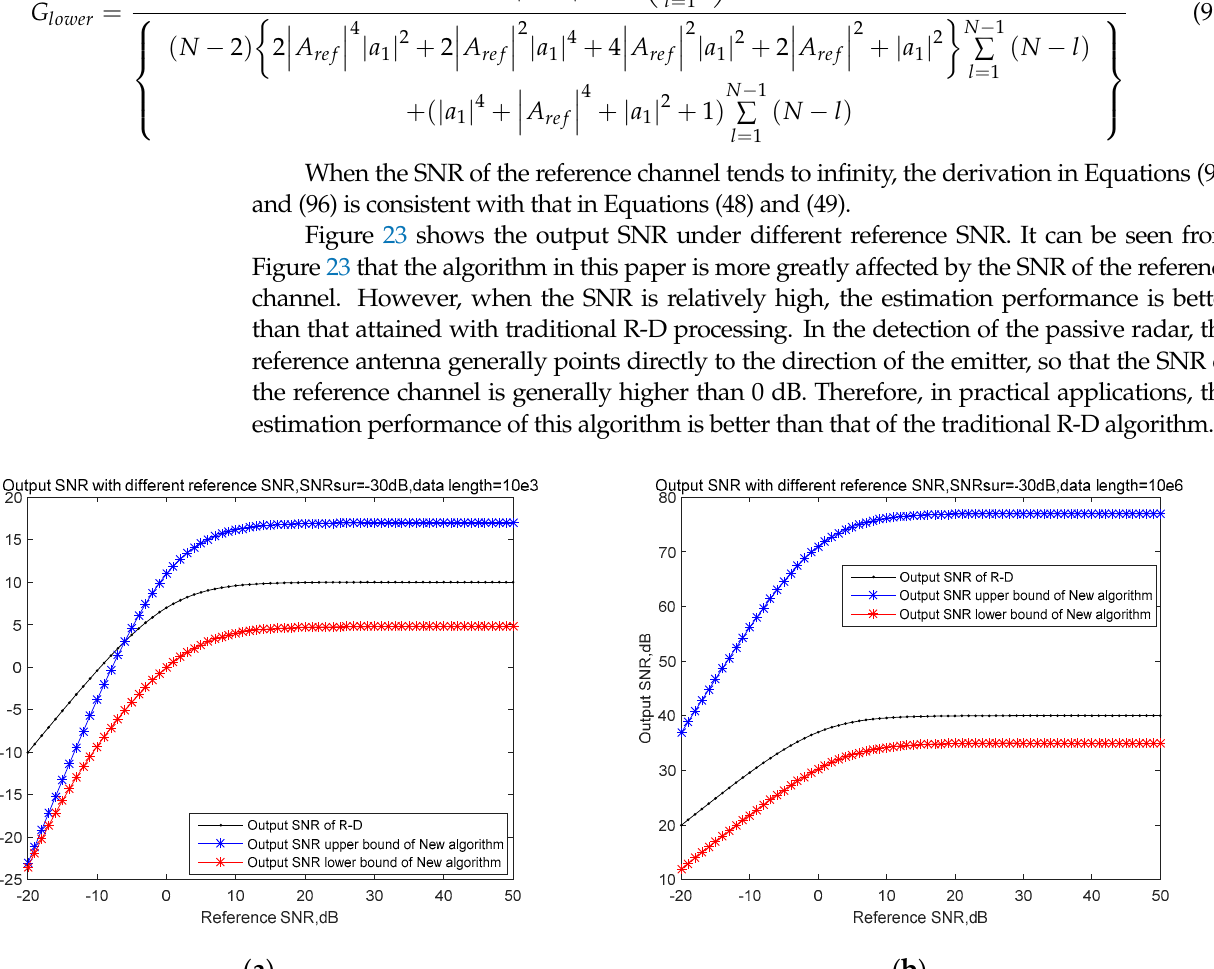
Figure 23. Output SNR under different reference SNR (SNR sur = − 30 dB: ( a ) N = 10 4 , ( b ) N = 10 6 ).